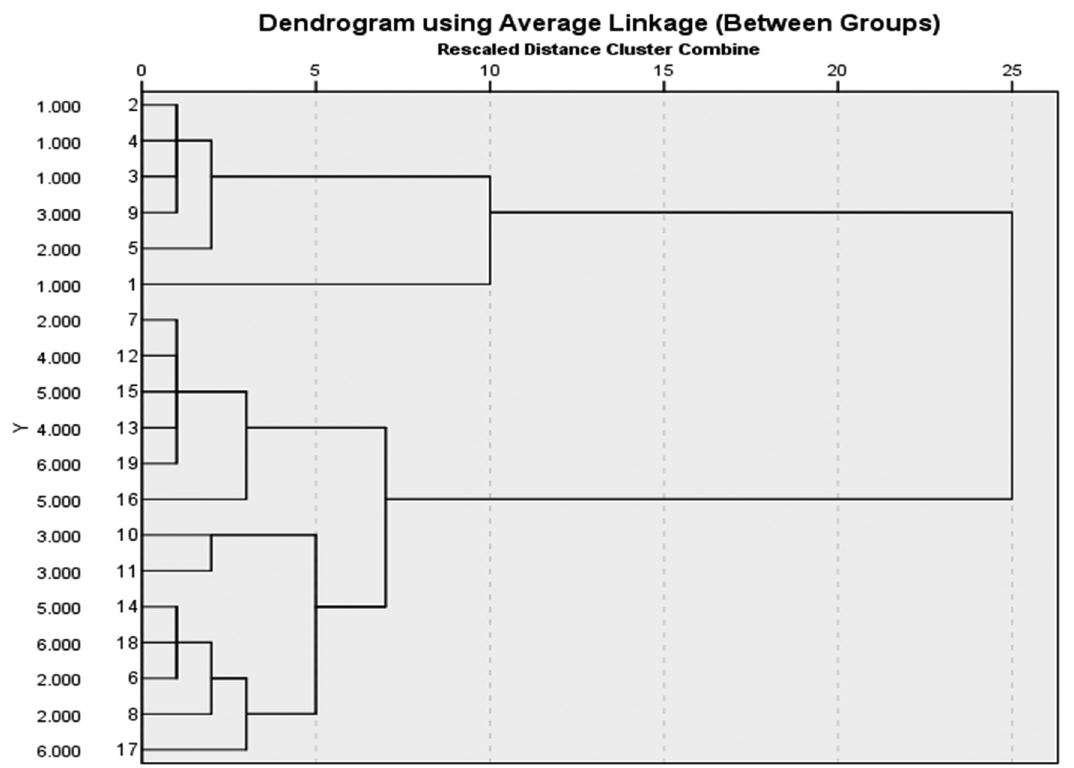
Figure 3: The agglomerative clustering of the milk samples according to the results of the studied parameters compared to the animal origin and altitude classi fi cation. The milk samples were grouped into six groups according to the origin and altitude as follows: 1 for camel milk from high altitude;, 2 for camel milk from low altitude,; 3 for goat milk from high altitude;, 4 for goat milk from low altitude,; 5 for sheep milk from high altitude,; and 6 for sheep milk from low